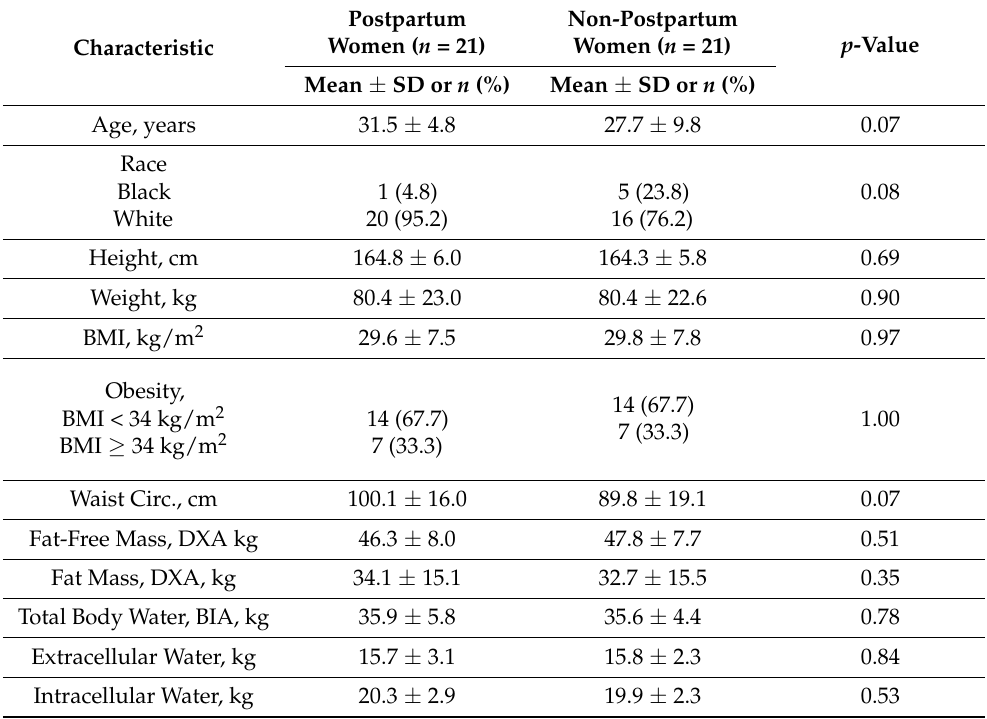
Table 1. Participant characteristics by group ( n =